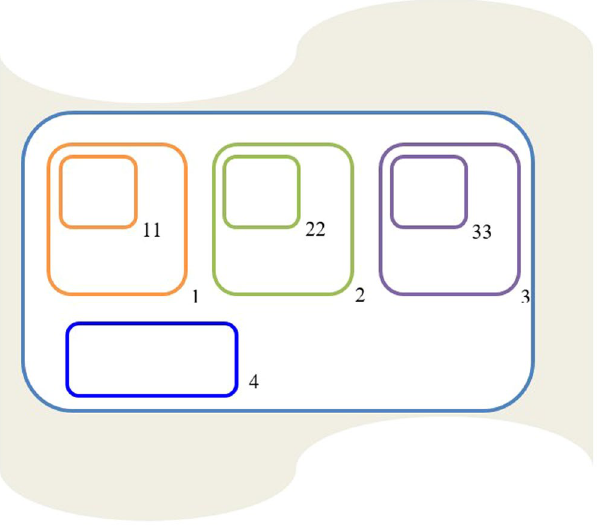
Figure 5. Structure of the membranes used in the population dynamic P system model designed for a pig farm.